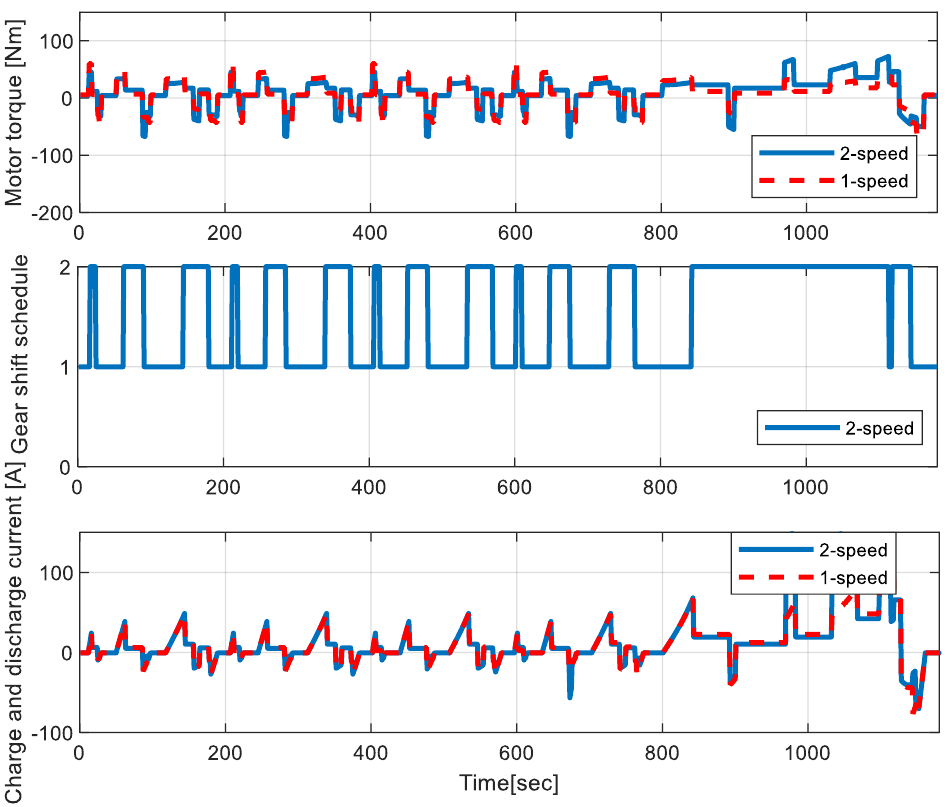
Figure 11. Comparison of system state trajectories of two gearboxes under NEDC cycle conditions. Energies 2020 , 13 , x FOR PEER REVIEW